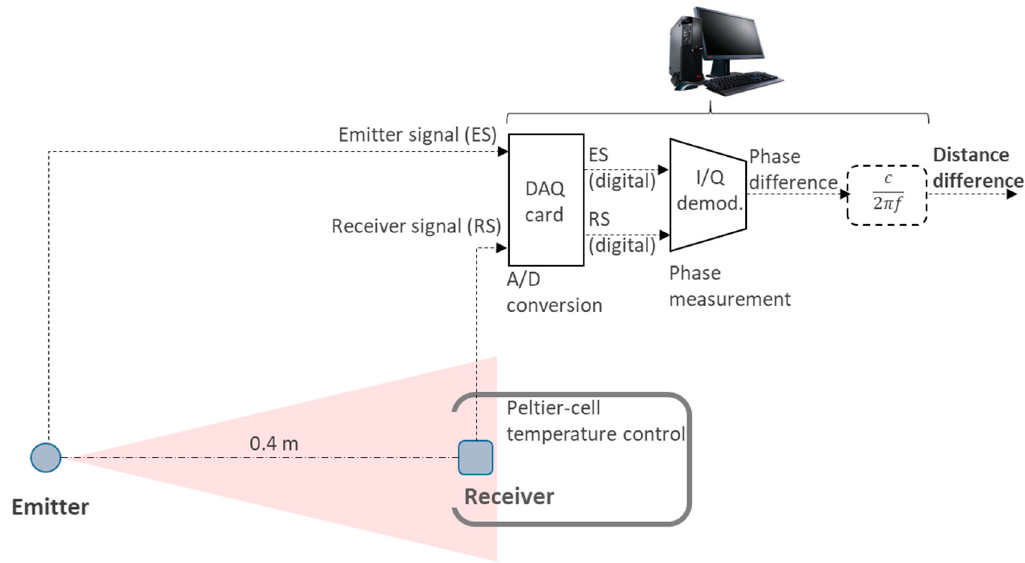
Figure 6. Test setup for the validation of the case study.